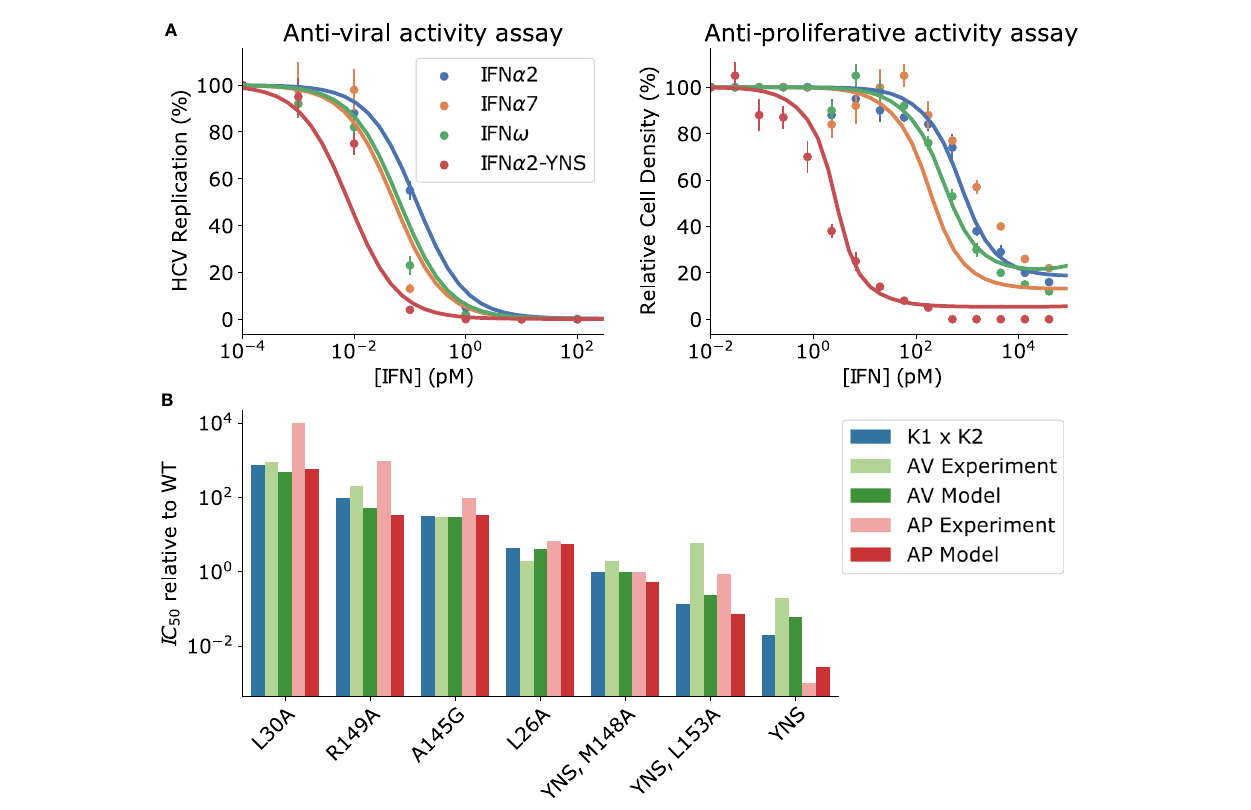
FIGURE 6 | Proximal receptor signaling maps to biological activity. (A) Points: measurements of biological activity from (39). Lines: phenomenological mapping (Eq. 5-6). IFN a 2-YNS is frequently used as an IFN b mimic because it has a similar af fi nity for IFNAR1 and IFNAR2 as wild-type IFN b . The antiviral activity was measured experimentally as the percentage of HCV-infected cells, while anti-proliferative activity was measured as the percentage of cells remaining alive after IFN stimulation for 48 hours. In both assays, maximal biological activity corresponds to minimal replication/cell density. (B) The anti-viral (AV) IC 50 (green) and anti-proliferative (AP) IC 50 (red) measured for a selection of IFN a 2 mutants is compared with the predicted IC 50 ’ s from Equations 5 and 6 respectively. The product of IFNAR1 and IFNAR2 dissociation constants for each IFN subtype is shown in blue, and is a good phenomenological approximation to IC 50 ; see Mathematical Methods